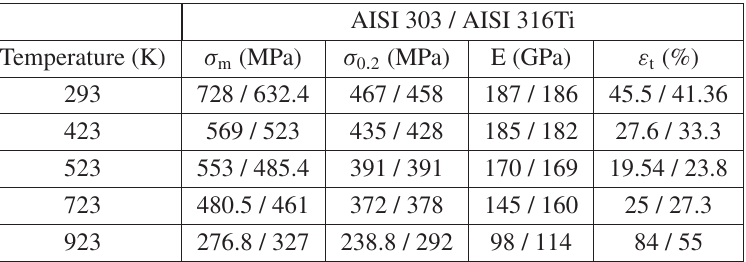
Table 1. Material mechanical properties ( (cid:2) m , (cid:2) 0:2 ), modulus of elasticity (E) and total strain ( " t / of AISI 303 steel and AISI 316Ti steel at room and elevated temperatures ( (cid:2) m – ultimate tensile strength, (cid:2) 0:2 – 0.2 percent offset yield strength).